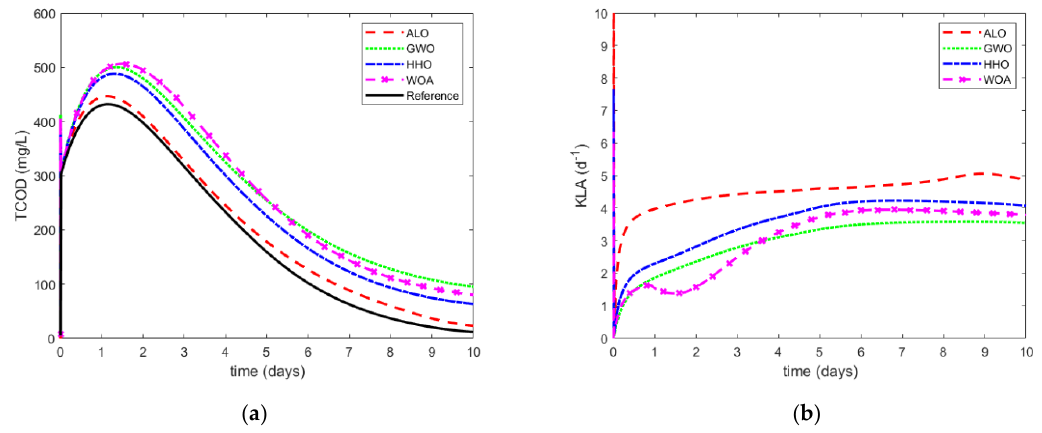
Figure 8. Tracking performance comparison in presence of external disturbance: ( a ) TCOD control and ( b ) KLA signal.